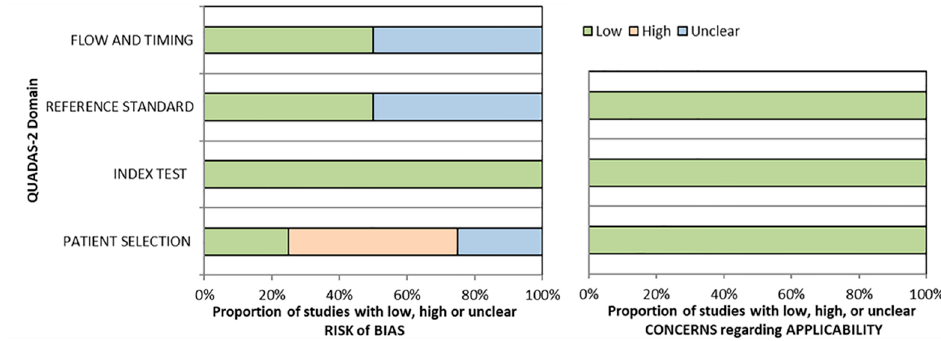
Figure 1. PRISMA flow diagram of included articles. PRISMA, Preferred Reporting Items for Systematic Reviews and Meta-Analyses.